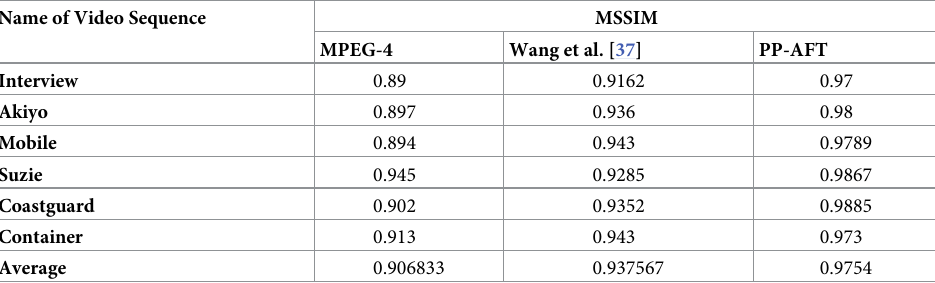
Table 2. MSSIM value for various test